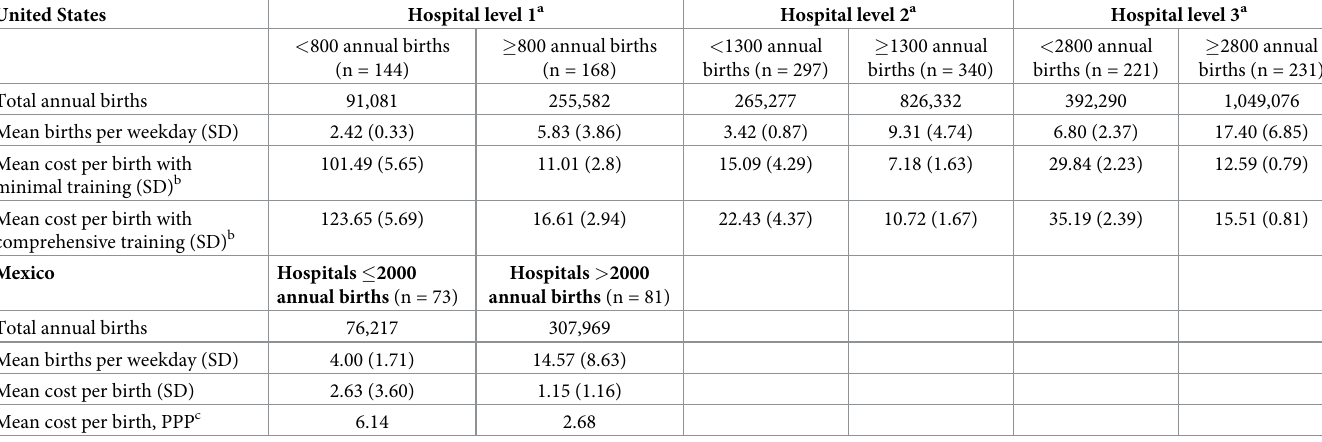
Table 8. Total hospital births and estimates of cost per birth (in USD) for BFHI training in the United States and